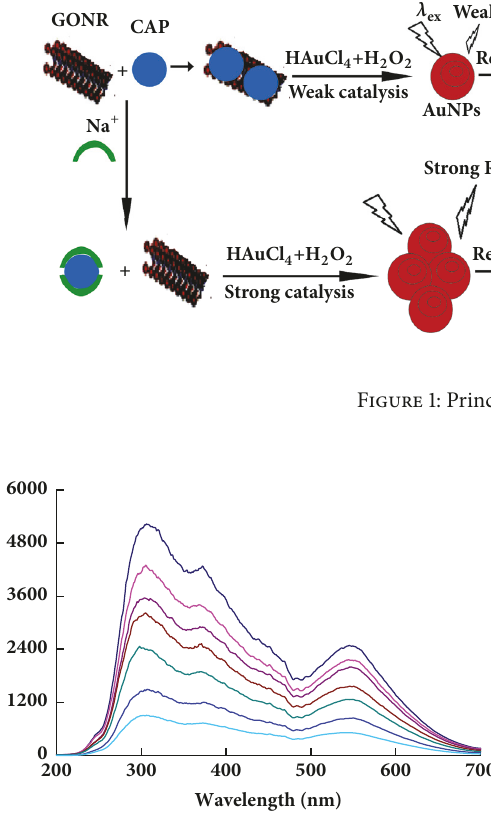
Figure 2: RRS spectra of CH 3 CH 2 OH-Na + -PA-GONR-H 2 O 2 - HAuCl 4 system. a:1.13 mol/L CH 3 CH 2 OH+ 3.14 𝜇 mol/L CAP+0.193 mmol/L HAuCl 4 +3.3 mmol/L H 2 O 2 +23.8 ng/mL GONR; b:a+0.69 nmol/L Na + ; c:a+4.3 nmol/L Na + ; d:a+8.6 nmol/L Na + ; e:a+12.9 nmol/L Na + ; f:a+17.2 nmol/L Na + ; g:a+25.8 nmol/L Na +